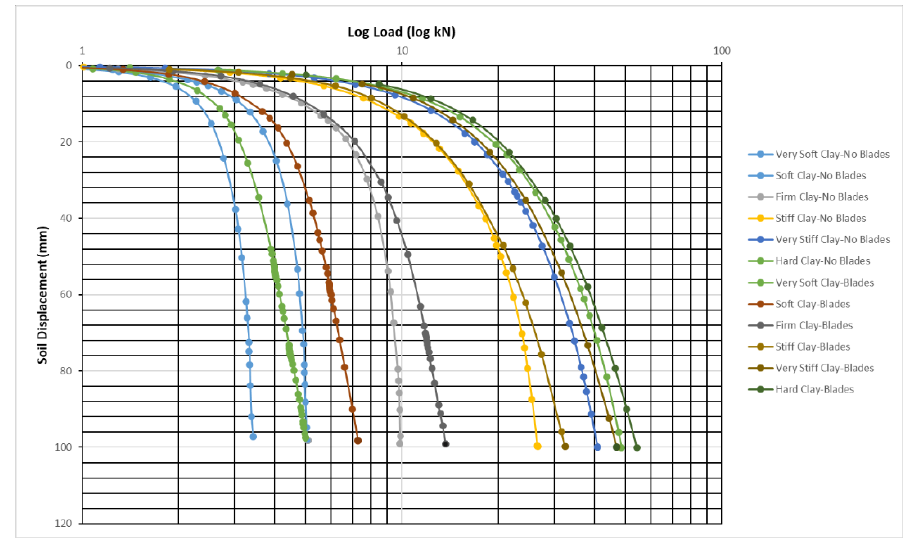
Figure 10. Log load versus soil displacement of CHSB 0 and CHSB 1 piles in clay. Table 11. Ultimate bearing capacity of normal and blade pile foundations in different types of